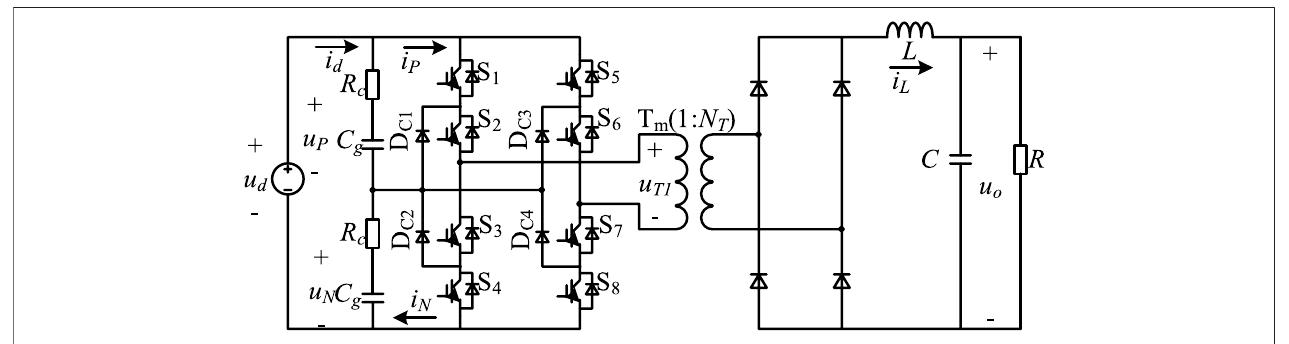
FIGURE 3 | Topology of the three-level H-bridge DC/DC converter.